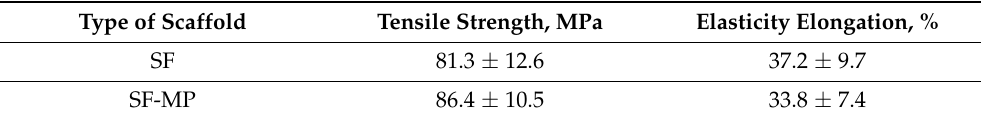
Table 2. Measurement data of tensile strength and elasticity of various samples of scaffolds based on silk fibroin. Standard deviation values for five independent measurements are shown.